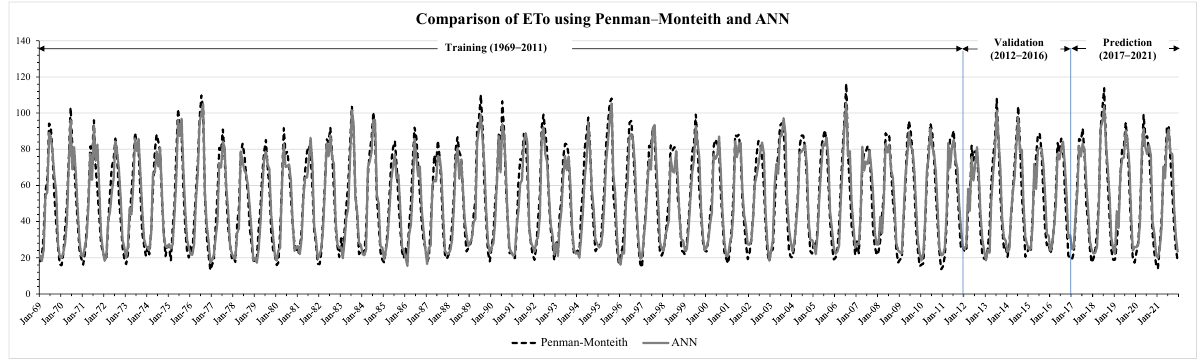
Figure 3. Time Series Comparison of PET using Penman–Monteith and